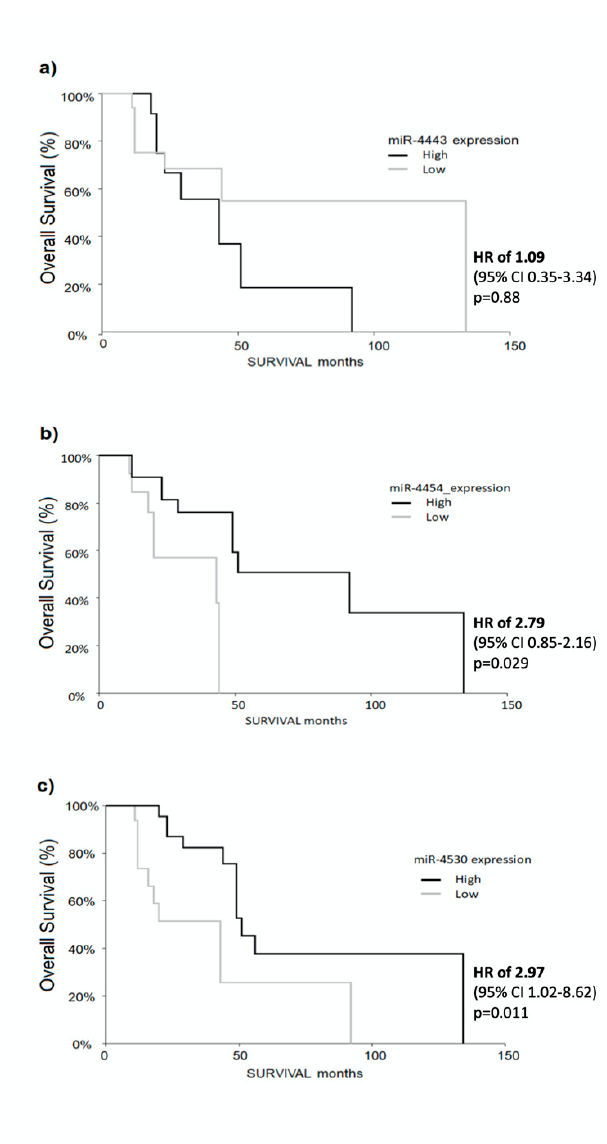
Figure 4. Kaplan–Meier survival analysis by log-rank test for miR-4454 ( a ), miR-4443 ( b ), and miR-4530 ( c ) at T0 for patients receiving curative therapies. It is demonstrated that high expression of miR-4454 and miR-4530 were significantly related to better overall survival in patients, with a hazard ratio (HR) of 2.79 (95% CI: 0.85–2.16, p = 0.029) (Figure 4b) and HR of 2.97 (95% CI: 1.02–8.62, p = 0.011). HR = hazard ratio.